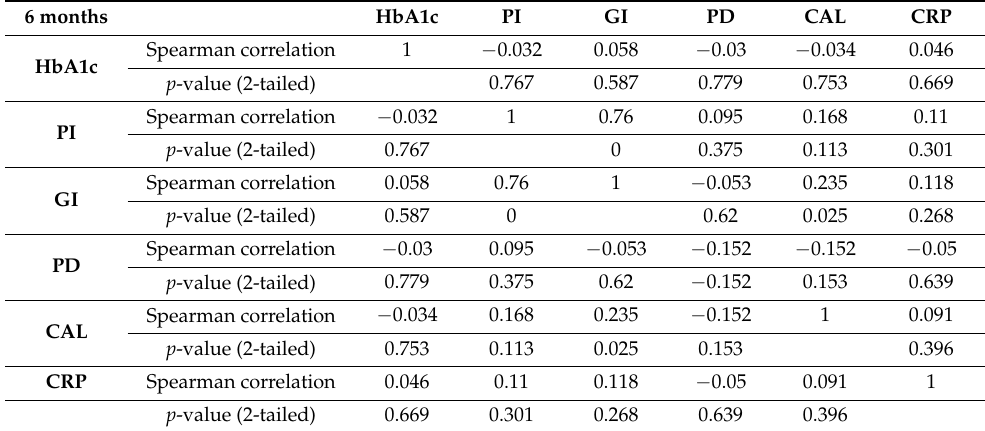
Table 5. Correlation and significance analysis between the HbA1c level and periodontal parameters of the intervention group at 6 months.